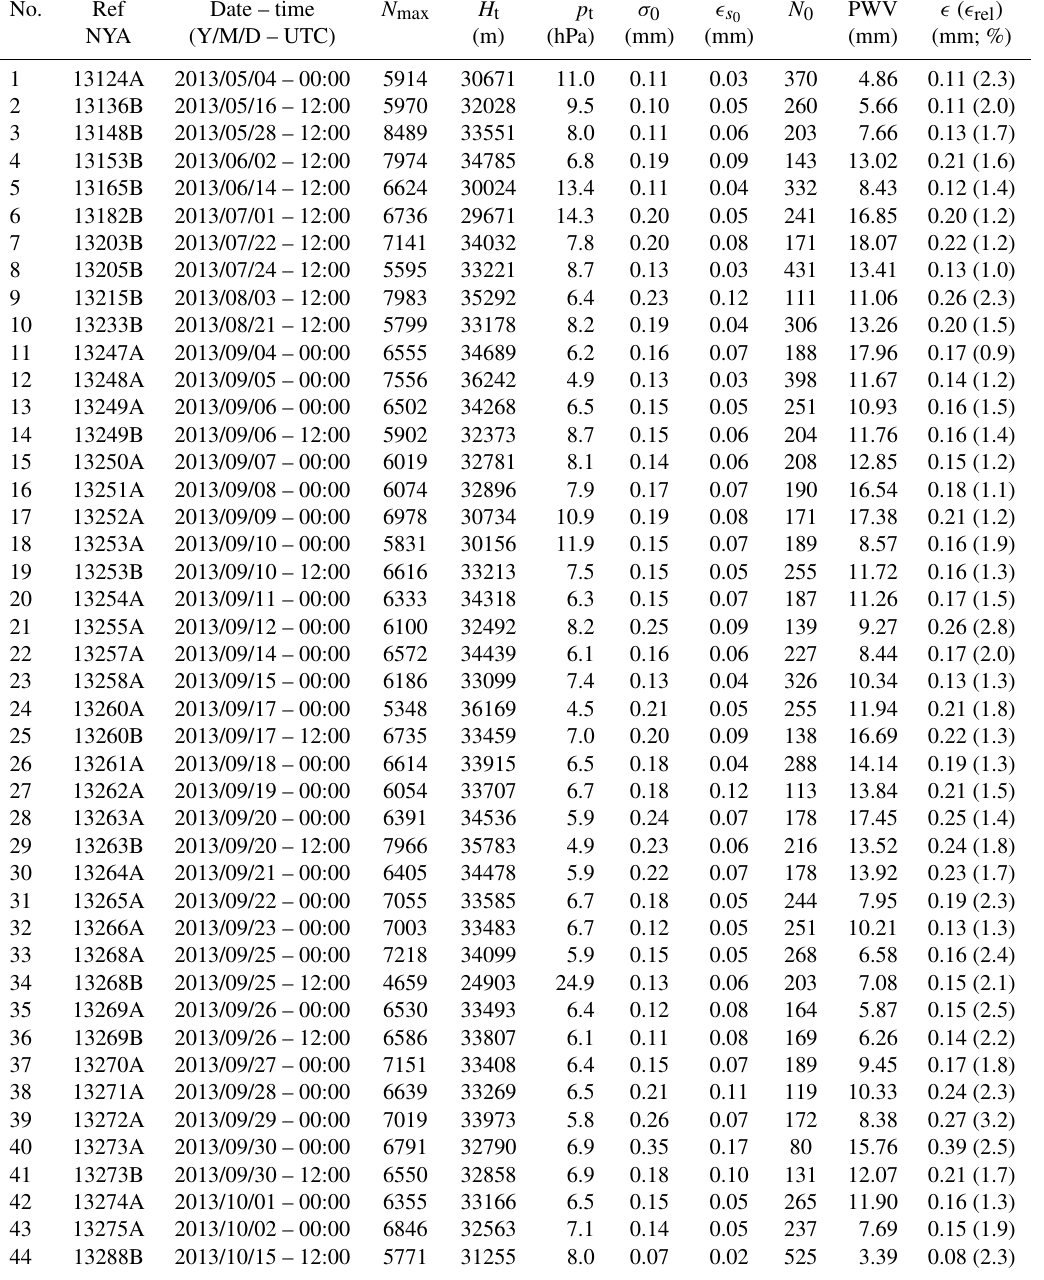
Table B4. PWV data and optimized error (cid:15) (see Eq. 19) from the radiosoundings at NYA. See the caption of Table B1 for